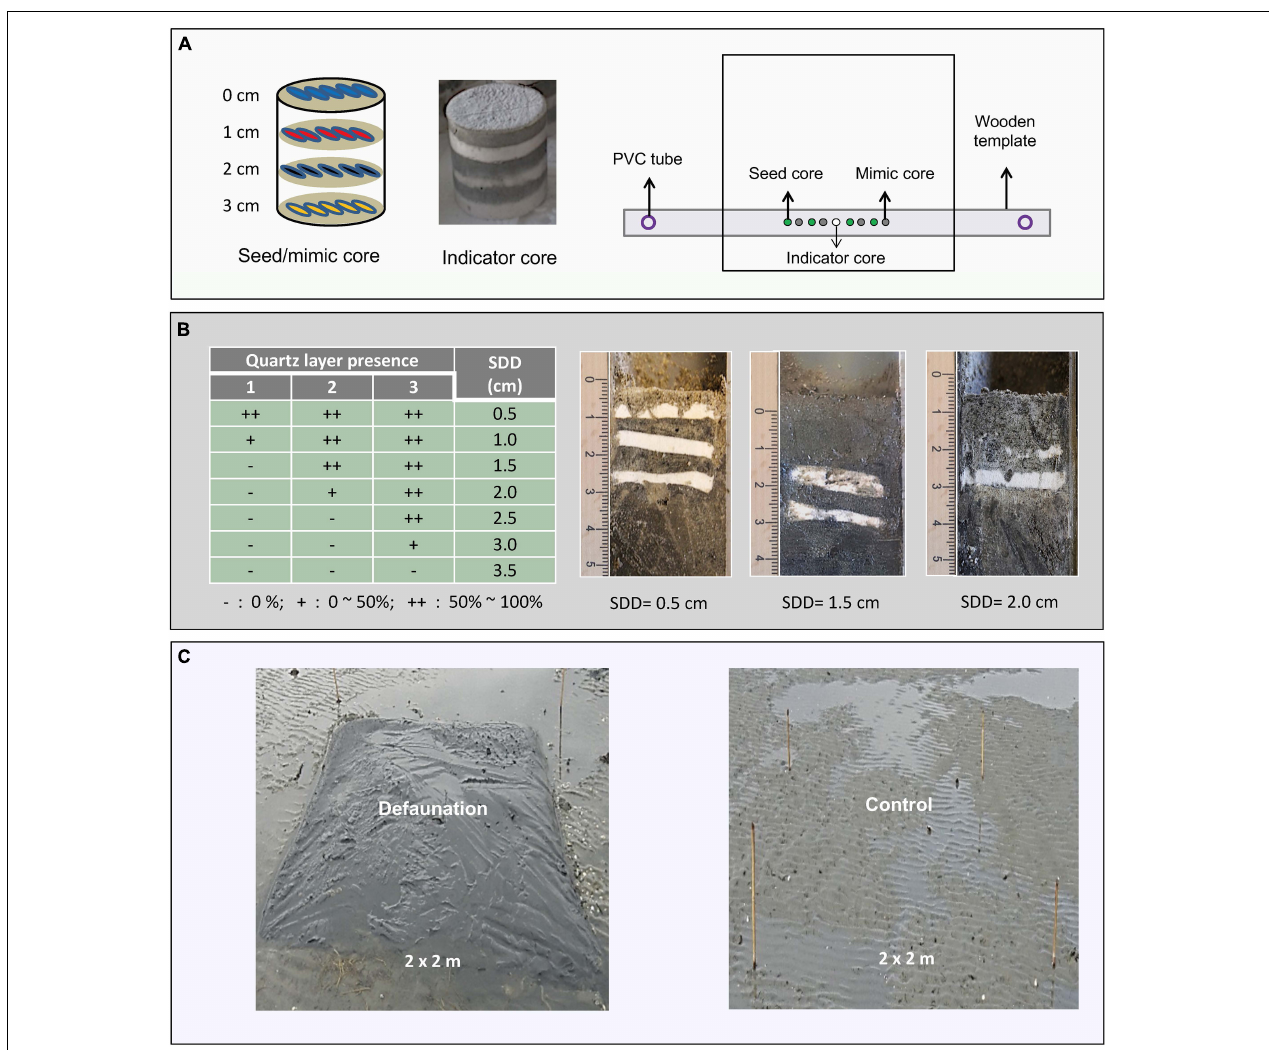
FIGURE 2 | (A) Seed bank core, indicator core, and their deployment in the plots. (B) Scoring rules and examples of sediment disturbance depth (SDD). (C) Defaunated and control